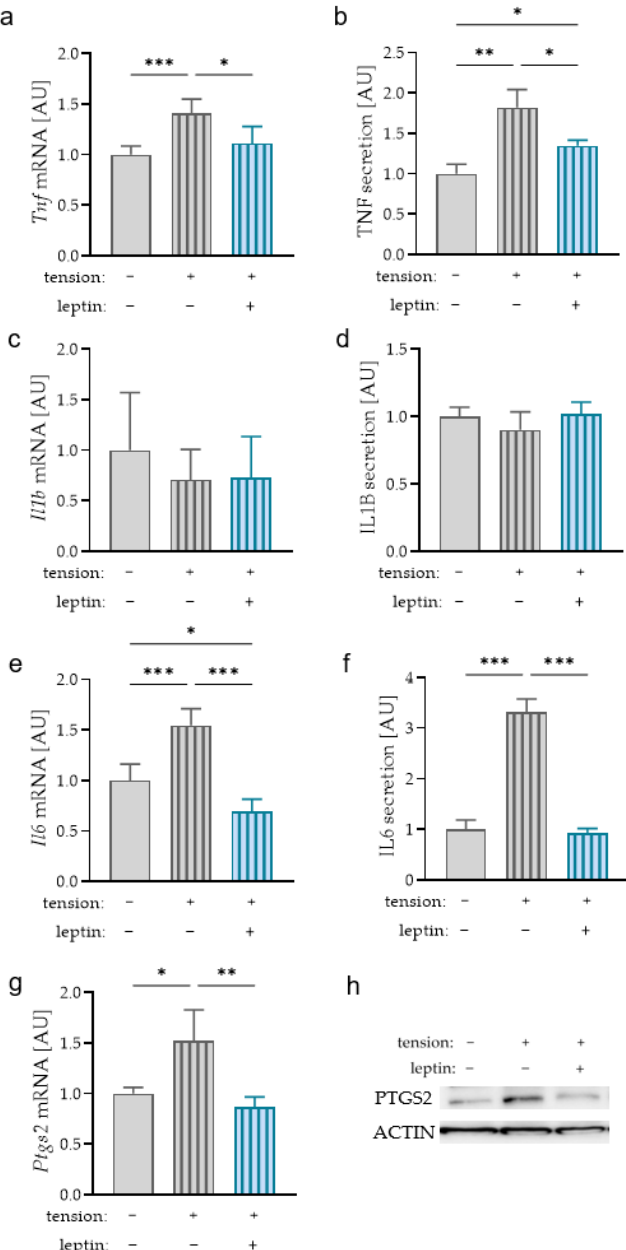
Figure 5. Impact of leptin in combination with tensile strain on TNF ( a , b ), IL1B ( c , d ), IL6 ( e , f ), and PTGS2 ( g , h ) gene and protein expression and secretion in RAW264.7 macrophages; n ≥ 4; Welch- corrected ANOVA with Dunnett’s T3 multiple comparisons test. * p < 0.05; ** p < 0.01; *** p < 0.001. Uncropped blot is presented in Figure S2.